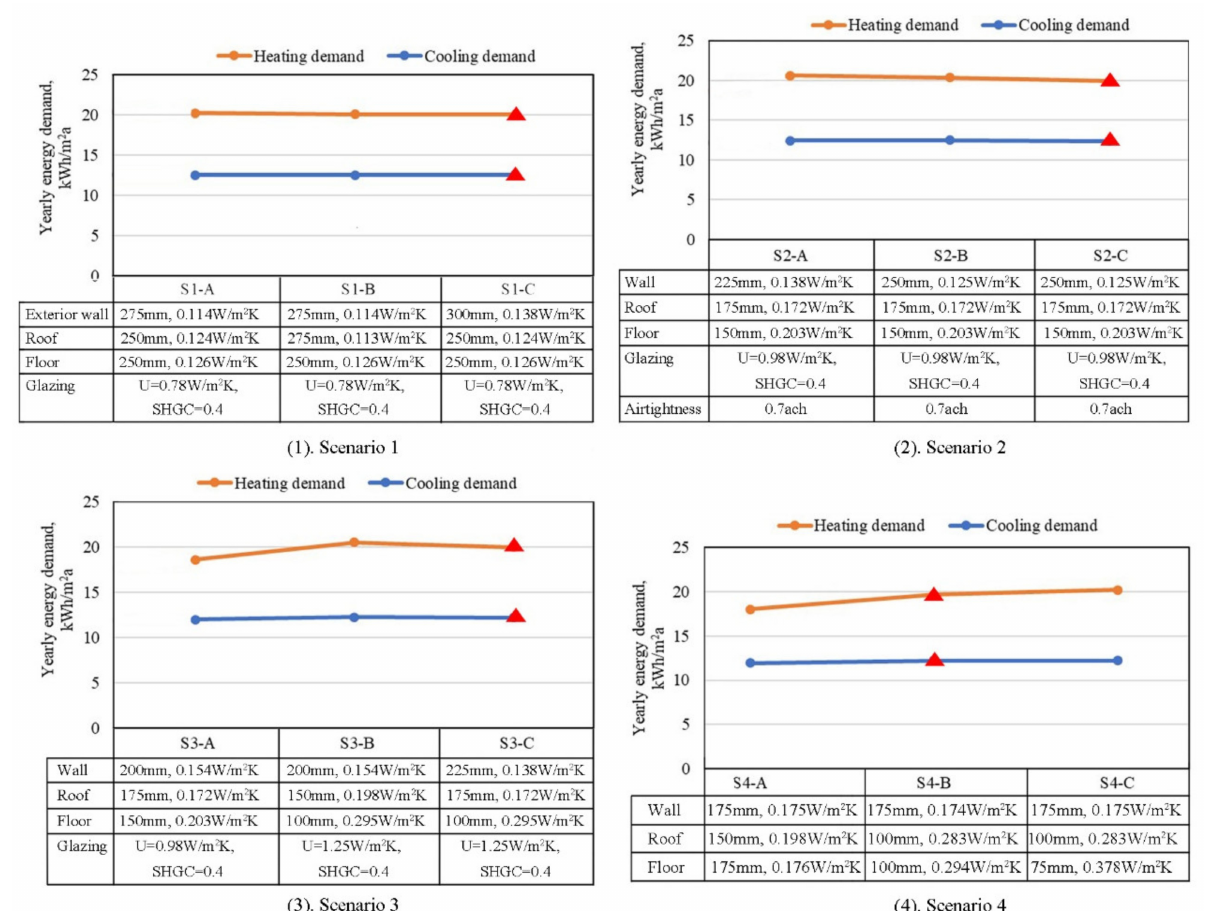
Figure 8. Simulated energy demands of the retrofitting combinations under the four scenarios, with the best solution marked in red.